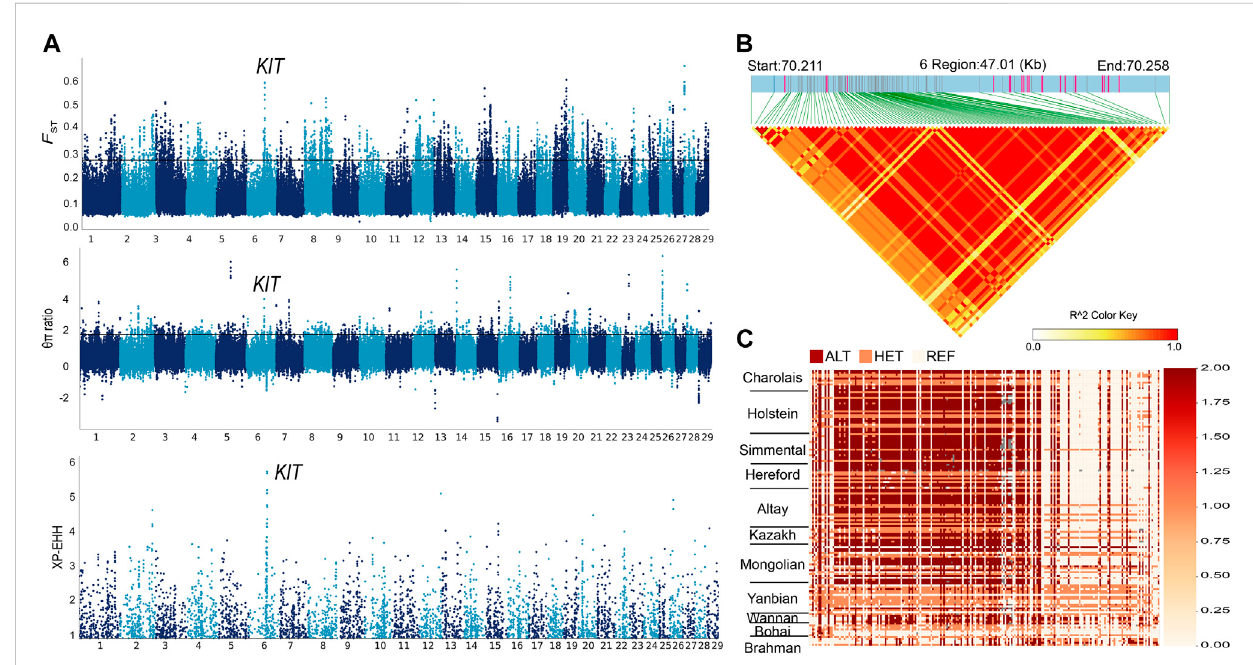
FIGURE 3 Selection signals in genomic areas of Altay white-headed cattle. (A) Manhattan plot of selected sweeps for Altay white-headed cattle and Bohai cattle ( F ST , θπ ratio and XP-EHH) (B) Haplotype block in LD with Altay white-headed cattle based on 103 SNPs. (C) Haplotype patterns were created using SNPs with MAFs greater than 0.05. (chr6: 70.21 – 70.25